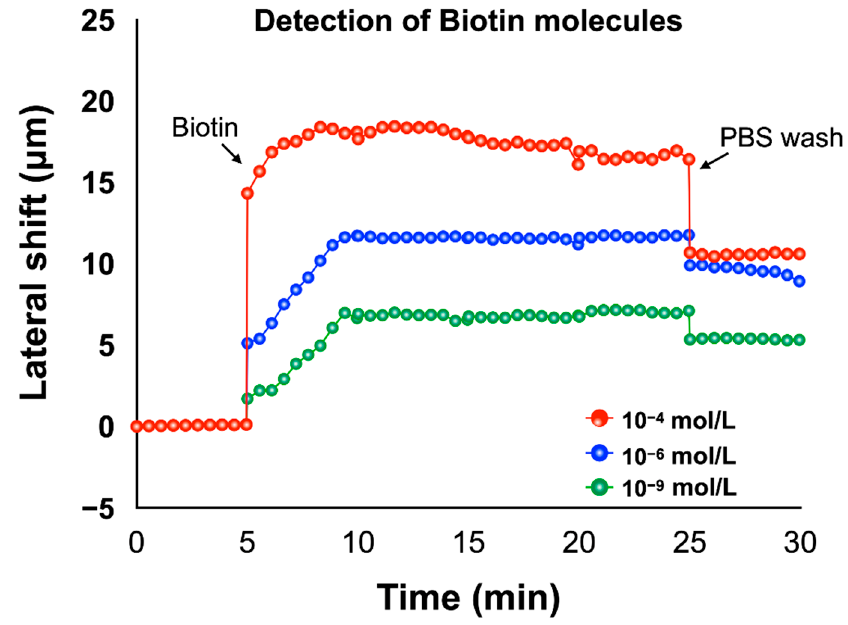
Figure 9. Real-time detection of biotin molecules based on lateral position shift measurement.